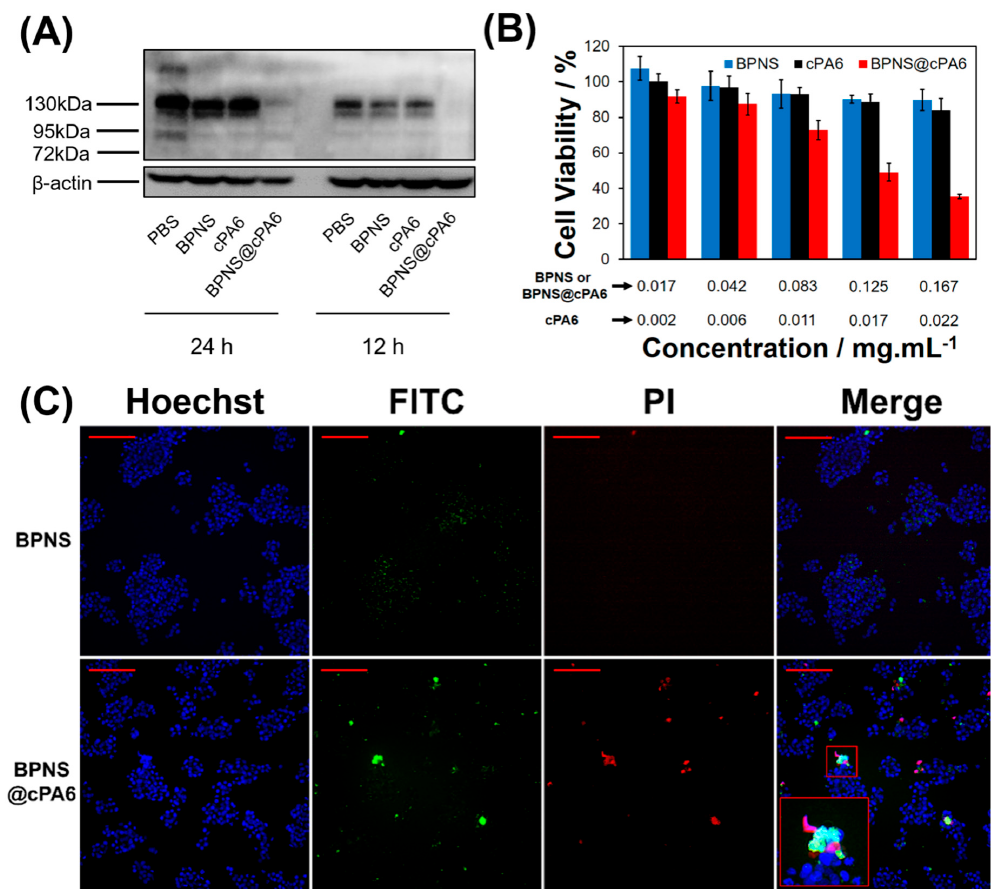
Figure 8. Effect of BPNS@ cPA6 on cells. ( A ) Western blot analysis of Tyr phosphorylation